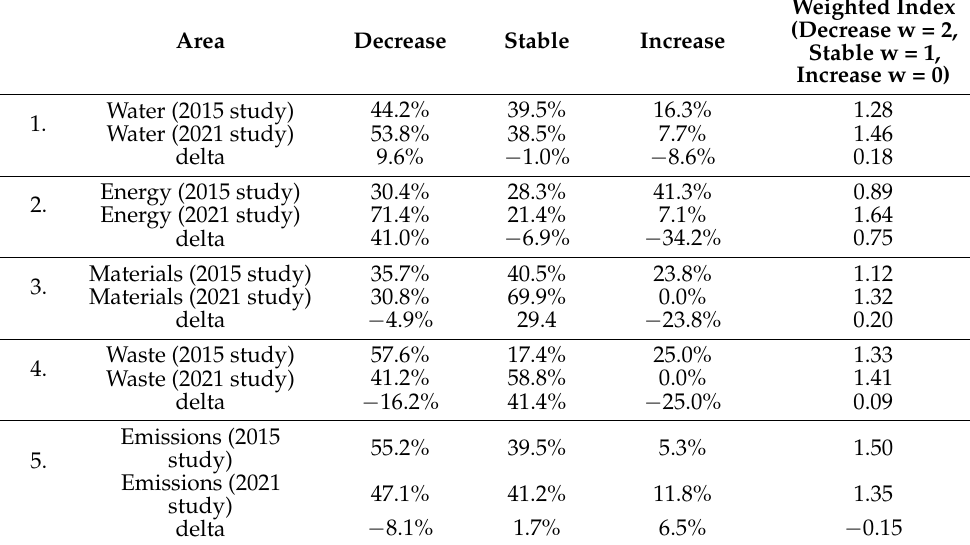
Table 3. Changes in environmental performance